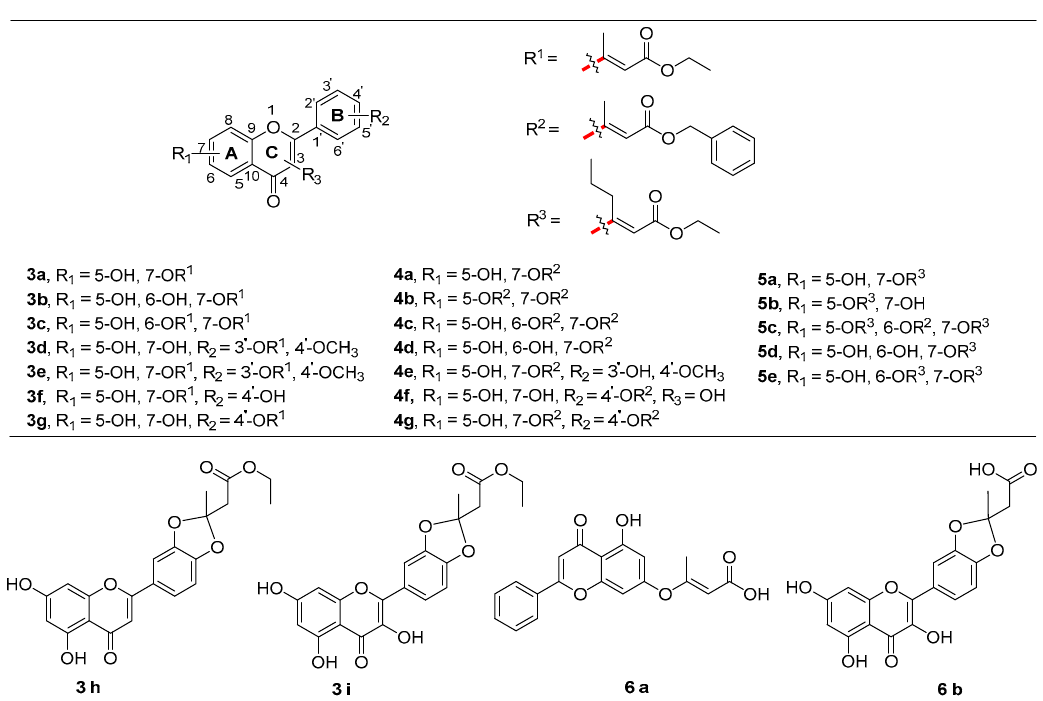
Figure 1. Types of allenes.